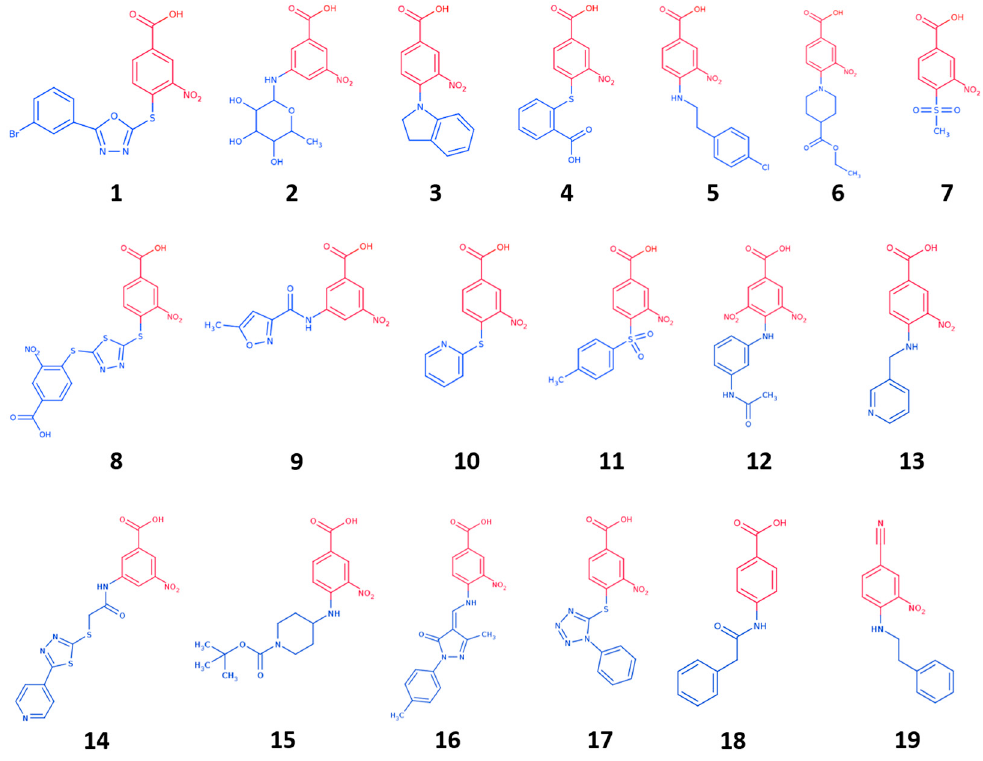
Figure 2. Chemical structure of selected GV2-20 derivatives. Head portions are colored red, tails are colored blue.